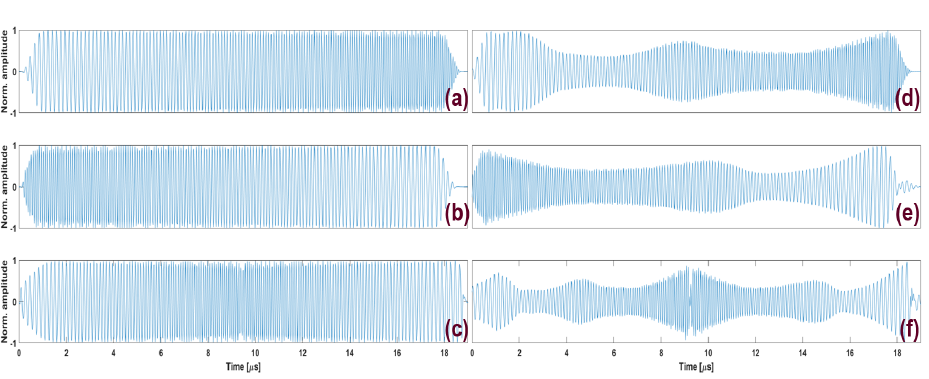
Figure 4. ( a – c ) Examples of three orthogonal e ( k ) ( t ) signals. This set of waveforms contains an ‘up’ chirp, a ‘down’ chirp, and a ‘up − down’ chirp. ( d – f ) Corresponding excitations a ( k ) ( t ) are used to drive a transducer of IR h ( t ) .